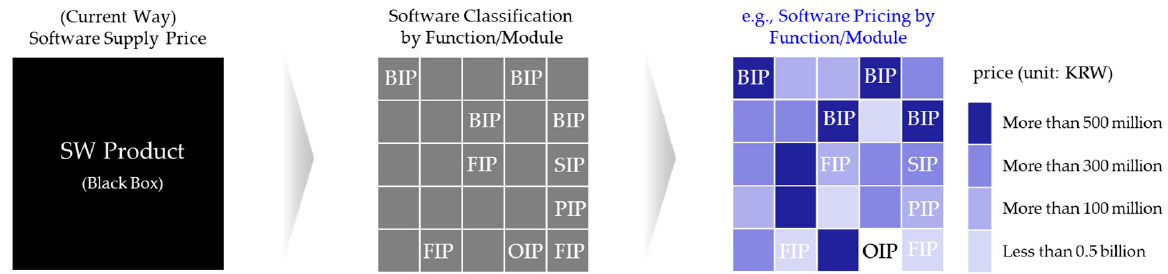
Figure 7. Software co-development concept.